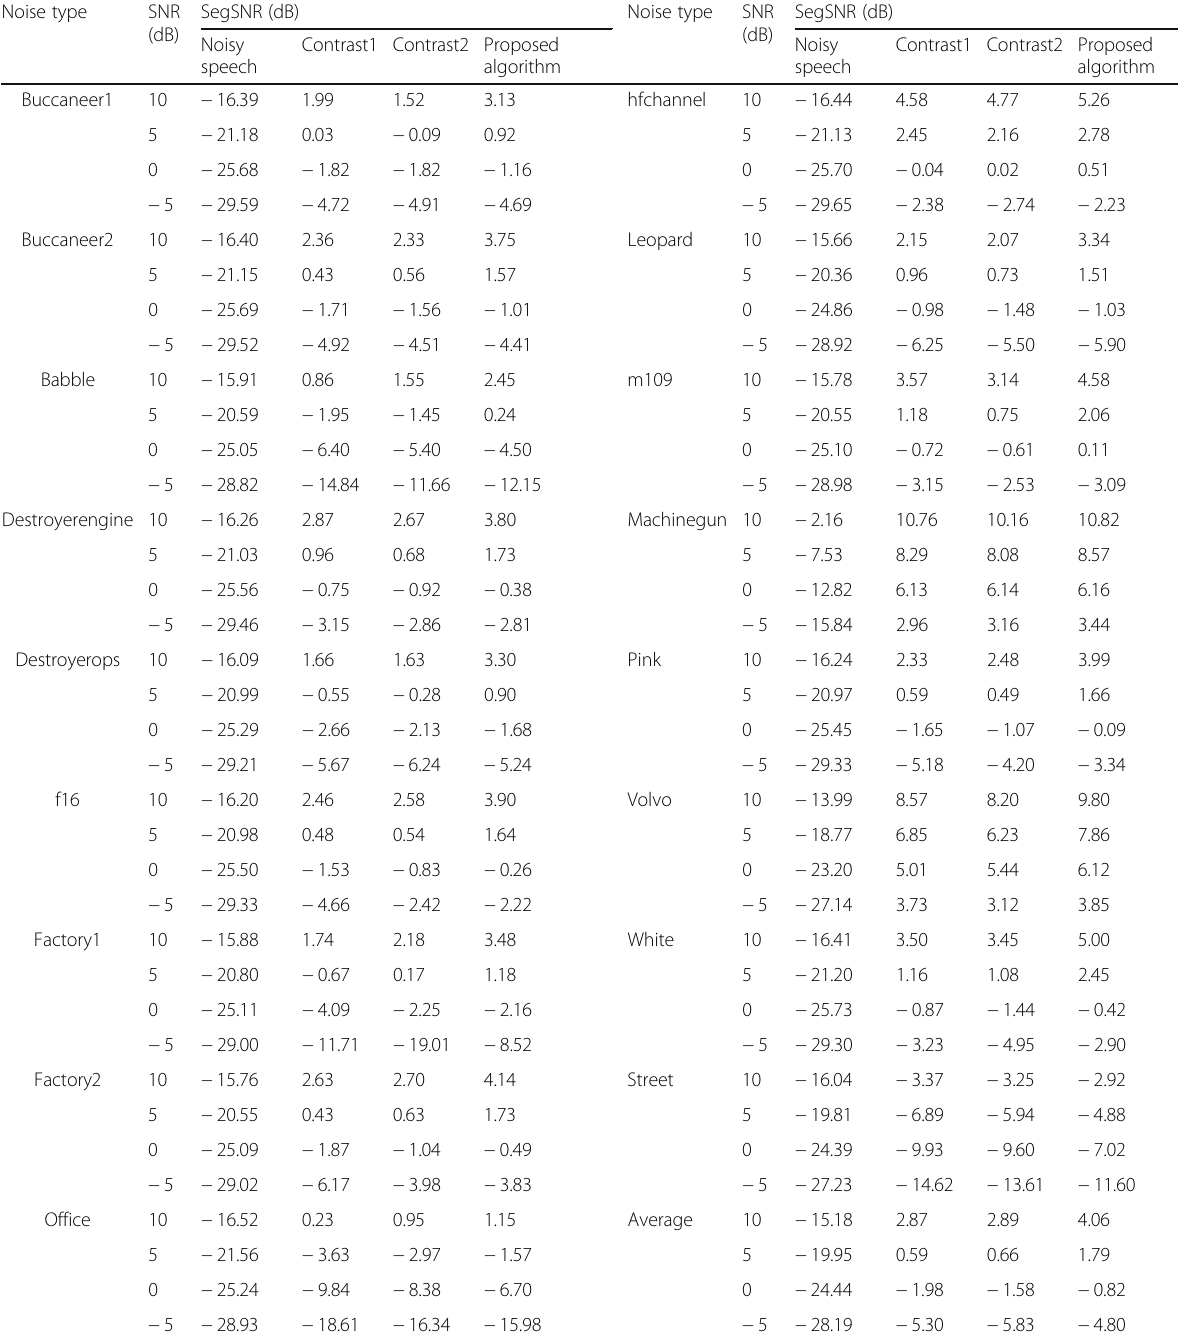
Table 1 The SegSNR of the proposed algorithm and the contrast algorithm Noise